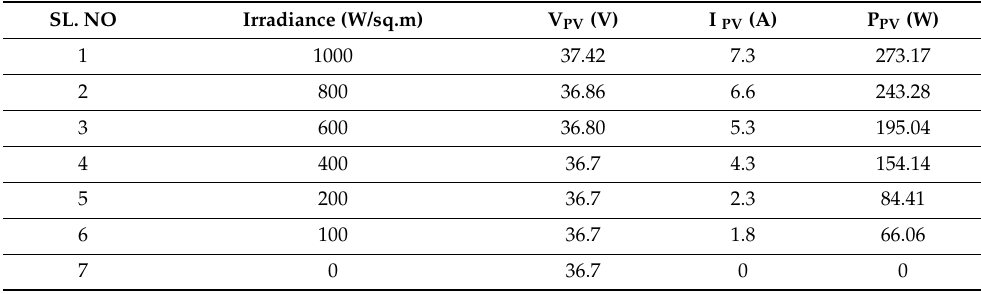
Figure A2. Control algorithm for the proposed multiport converter. The results of MPPT algorithm representing the output of PV panel at variable irradiance are shown in Table A1. This algorithm was set in the MPPT controller. By applying the MPPT algorithm (fractional open circuit voltage technique), output power was obtained at maximum voltage. From the table, it was observed that the current varied with the irradiance and the maximum power was obtained at the highest irradiance. Table A1. Results of MPPT algorithm—output of PV panel at variable